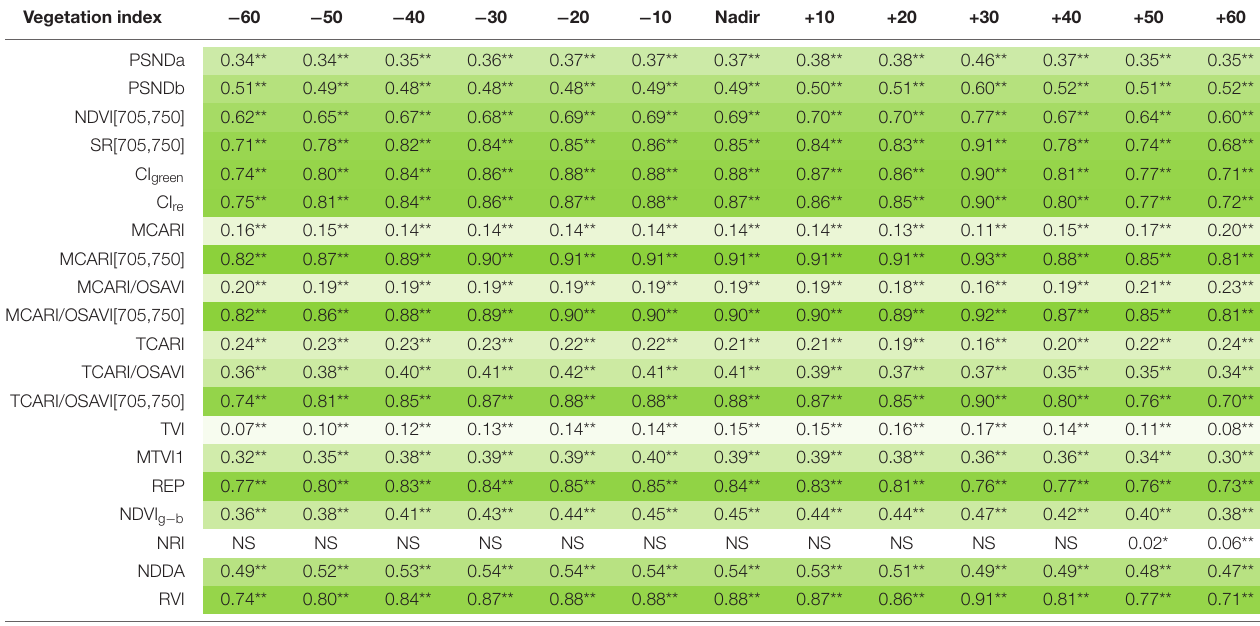
TABLE 4 | The R 2 values of estimation models between canopy chlorophyll content and VIs at different viewing angles. Vegetation